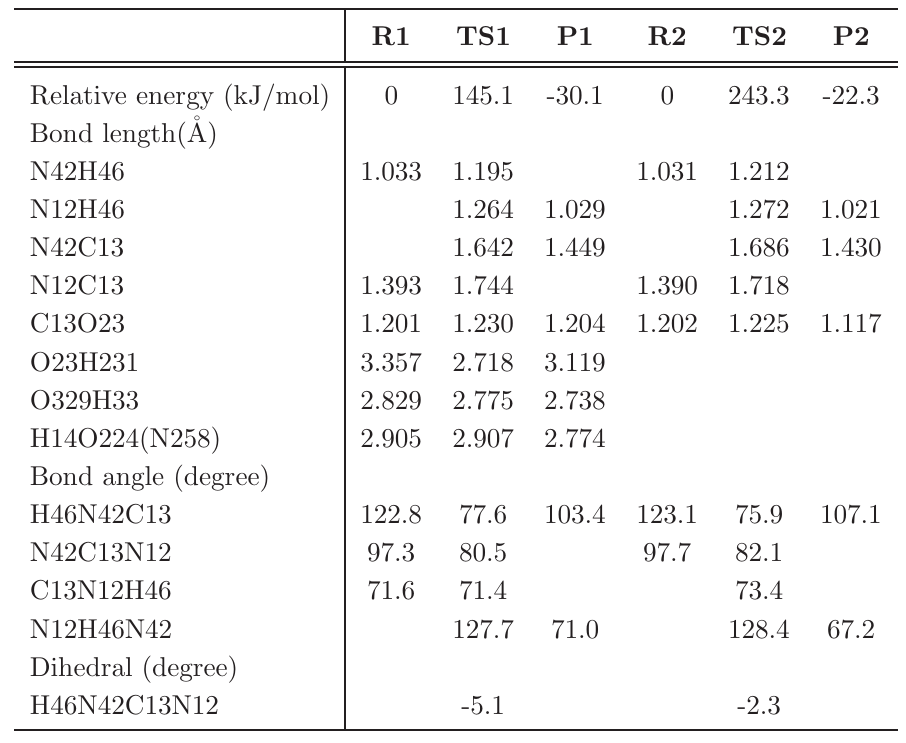
Table 1 Optimized structure data of reactants, products and transition states together with their relative energies in the one-carbon unit transfer